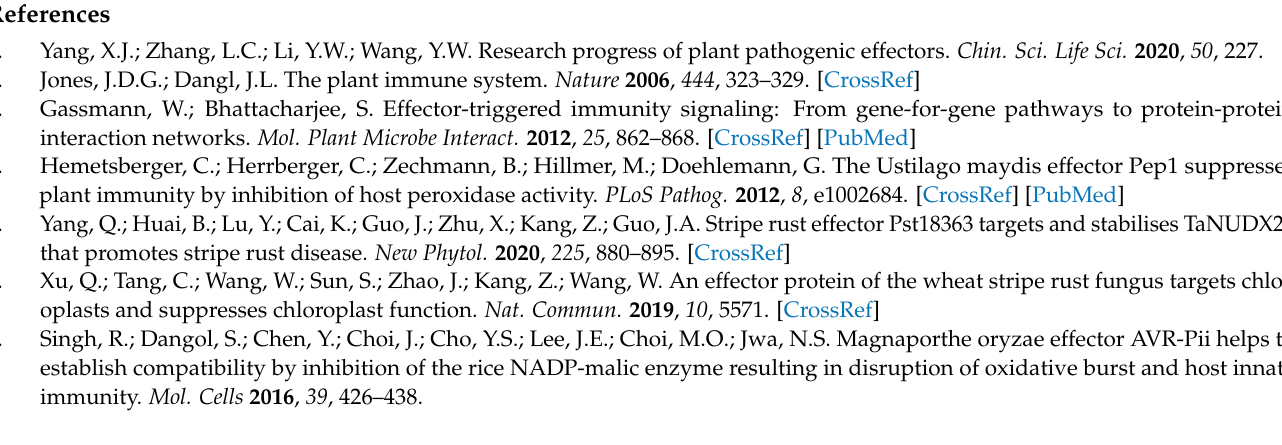
ApCE22; Figure S2: One-to-one yeast two-hybrid results of ApCE22 and the interacting proteins; Figure S3: The gene detection results of recombinant plasmid pSPYNE(R) 173-ApCE22, pSPYCE(M)- B2, and pSPYCE(M)-DnaJ. Figure S4: Analysis of the transmembrane region, signal peptide and hydrophilicity of the sequence of the effector ApCE22; Figure S5: Analysis of the transmembrane region, signal peptide, and hydrophilicity of the effector B2; Figure S6: Analysis of the transmembrane region, signal peptide, and the hydrophilicity of the sequence of the effector DnaJ. Figure S7: Elec- trophoresis results of the purified protein of the effector ApCE22, and the target proteins B2 and DnaJ. Figure S8: Western blot results of the effector ApCE22, the B2 protein, and the DnaJ protein. Table S1: Primer sequences of various expression vectors. Table S2: List of different plasmid ingredients in the self-activation and toxicity